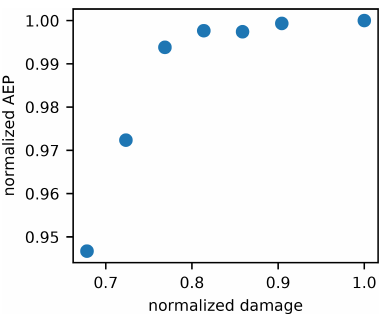
Figure 14. Pareto front displaying the trade-offs between maximiz- ing AEP and minimizing turbine damage. Both axes have been nor- malized by the AEP and maximum turbine damage achieved with- out constraining the turbine